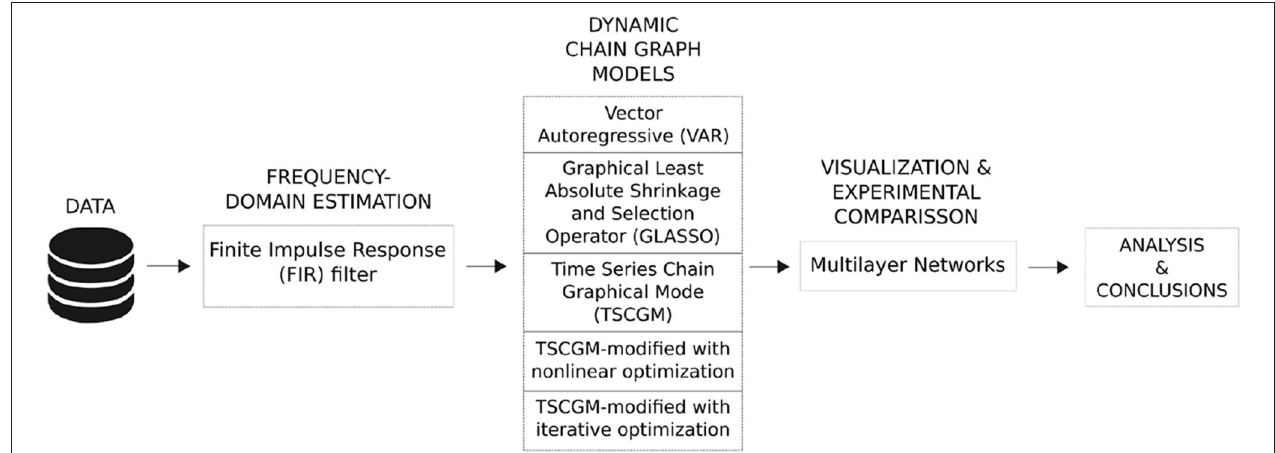
FIGURE 3 | Visual summary of the methodological framework. Only one participant/trial was selected, and its biosignals were extracted using EEG during baseline period and 2 mA post-stimulation in order to compare the brain dynamic responses. As a pre-processing phase, an FIR filter was applied in the raw EEG signal aiming to estimate the brain frequency-domain phases. Then, five types of dynamic chain graph models were tested and compared, for instance, illustrated only with the filtered EEG alpha band. Later, all the bandpower were compared, given the outperformed model comparing resting-state vs. port-stimulation electrical brain dynamic.